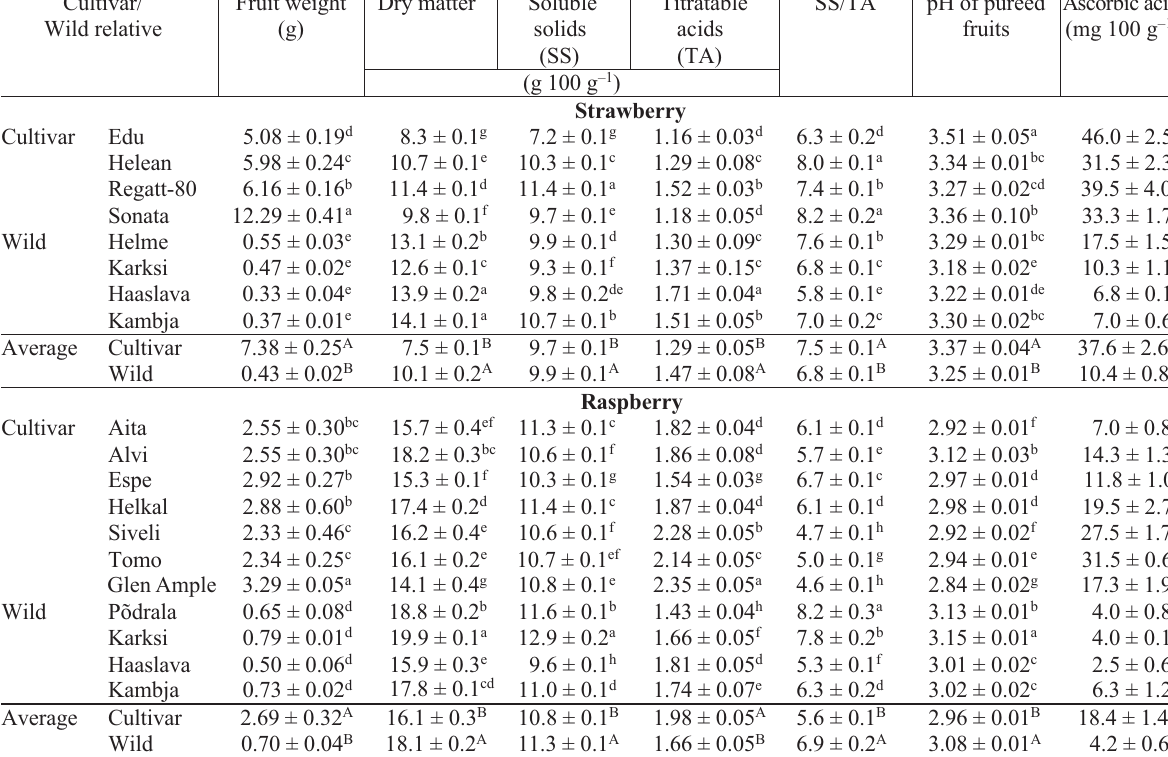
Table 1. Physio­chemical characteristics (mean ± standard deviation) of strawberry ( Fragaria × ananassa ) and raspberry ( Rubus idaeus ) cultivars, wild strawberry ( F. vesca ), and wild raspberry ( R. idaeus